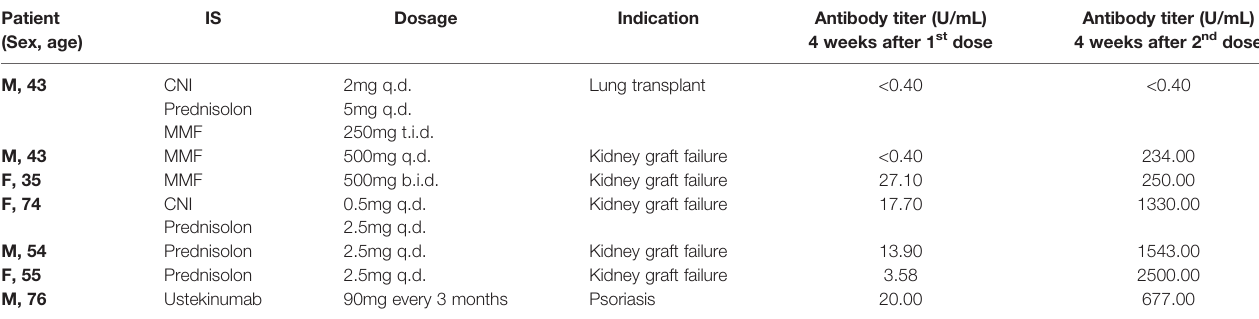
TABLE 2 | Antibody titers after mRNA-1273 vaccination in peritoneal dialysis patients with immunosuppressive therapy. Patient IS